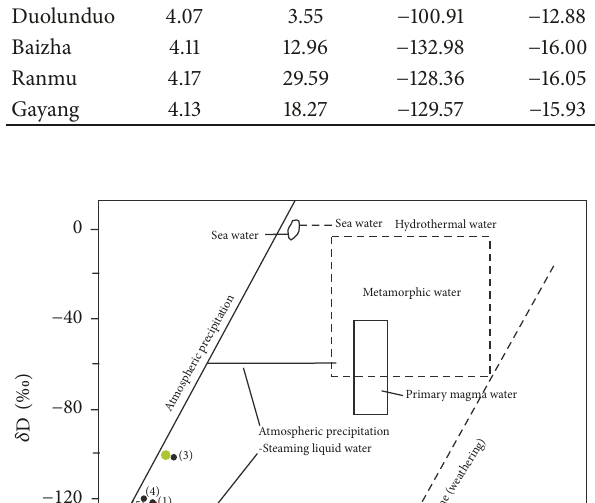
Figure 3: Relationship between the B/Cl and Na/Cl molar ratios.